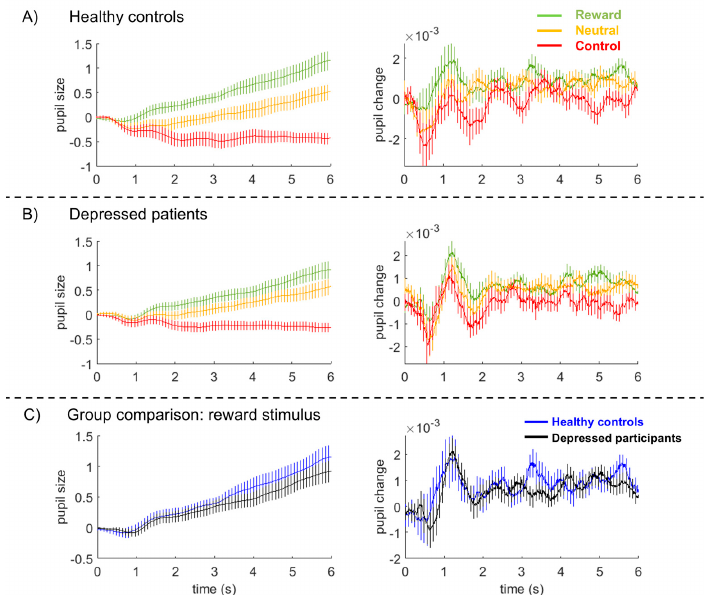
Figure 2. Pupil size (left panels) and pupil dilation (right panels) during presentation of the three stimuli in healthy control subjects ( A ) and depressed participants ( B ), averaged across all subjects and trials. ( C ) Average pupil size and pupil change / dilation during presentation of the reward stimulus. Pupil values are z-transformed, vertical bars represent 95% confidence